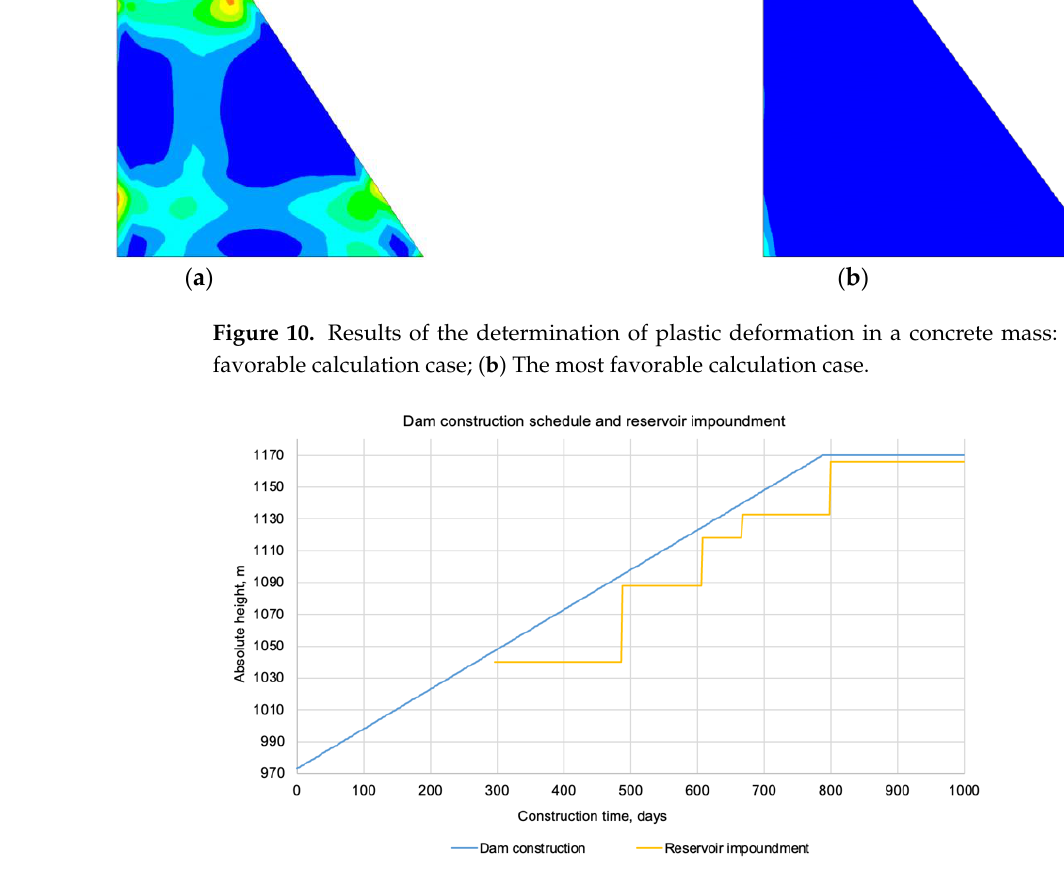
Figure 10. Results of the determination of plastic deformation in a concrete mass: ( a ) The least fa- vorable calculation case; ( b ) The most favorable calculation case.